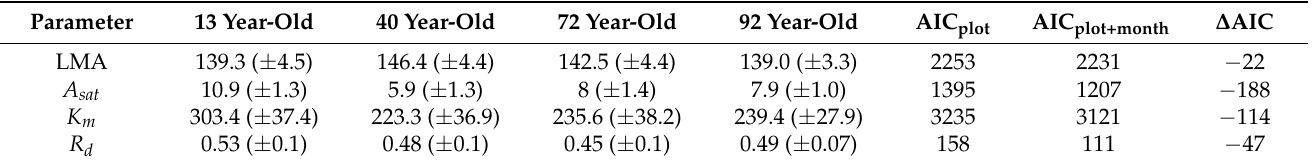
Table 4. Plot-specific fixed effect estimates ( ± 1 standard error) for Leaf Mass per Area (LMA, g m − 2 ), saturated net photosynthetic rate ( A sat , µ mole m − 2 s − 1 ), half saturation coefficient ( K m , µ mole quanta m − 2 s − 1 ) and dark respiration rate ( R d , µ mole m − 2 s − 1 ). AIC plot indicates the AIC for a simple linear regression with plot, while AIC plot+month indicates the AIC when seasonal variation was taken into account by including a monthly random component. ∆ AIC indicates the difference between AIC plot+month and AIC plot